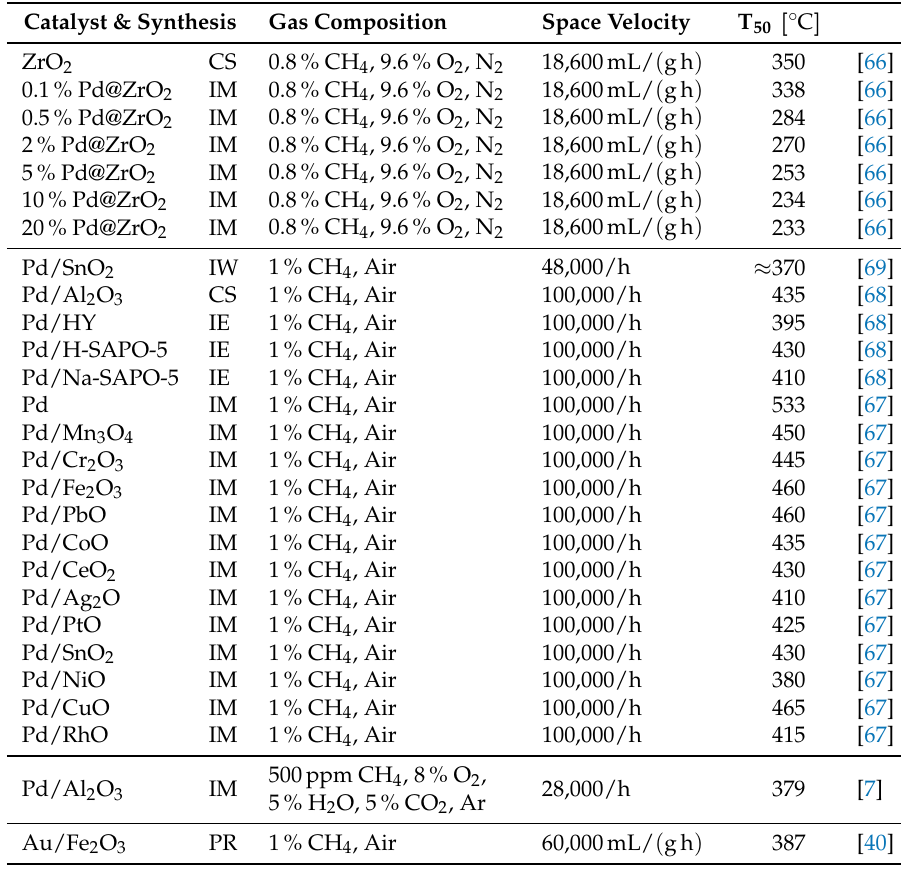
Table 4. Previously published T 50 values from different sources. Catalyst and synthesis method as well as gas composition and space velocity are given. † : Ce 0.64 Zr 0.16 Bi 0.20 O 1.90 ; CS: commercial sample, IM: impregnation, IW: incipient wetness, IE: ion exchange, PR: precipitation, HT: hydrothermal,